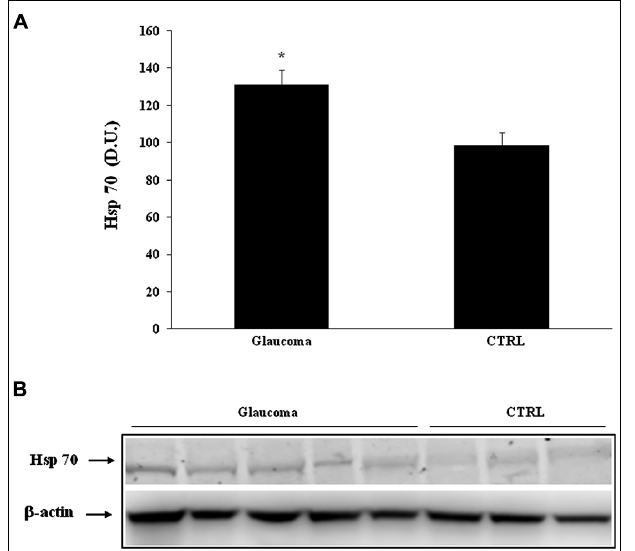
FIGURE 4 | (A) HO-1 protein levels in lymphocytes of glaucoma and control subjects. Samples from control and patients with glaucoma were assayed for HO-1 expression byWestern blot. A representative immunoblot is shown. β -actin has been used as loading control. (B) Densitometric evaluation: the bar graph shows the values are expressed as mean standard error of mean of 3 independent analyses. * P < 0.05 vs. control. D.U., densitometric units; CTRL, control.